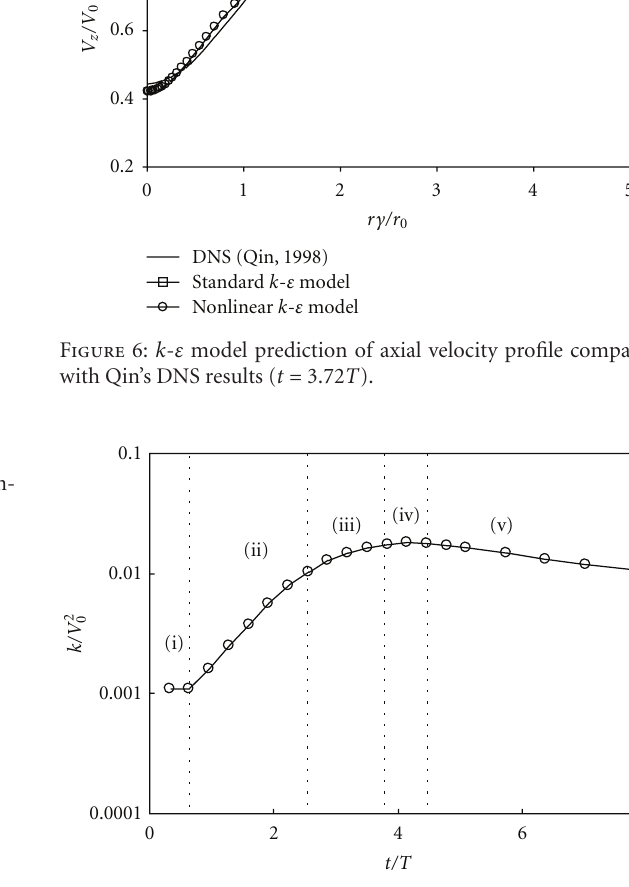
Figure 7: Growth/decay of turbulent kinetic energy with di ff erent time periods (nonlinear k - ε